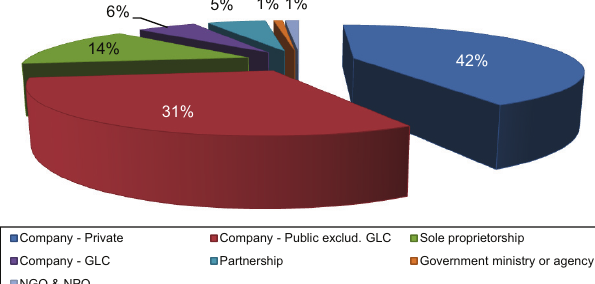
Figure 1. Composition of